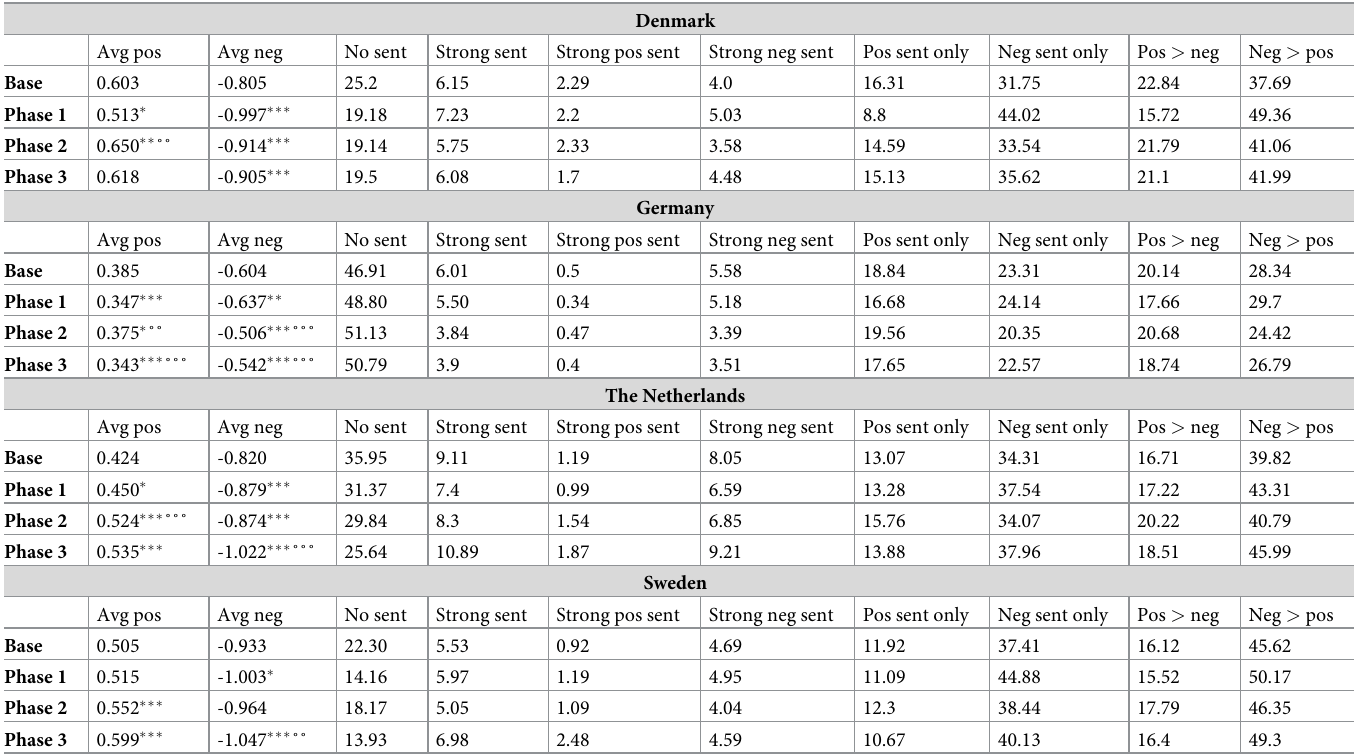
Table 4. Sentiment analysis results in